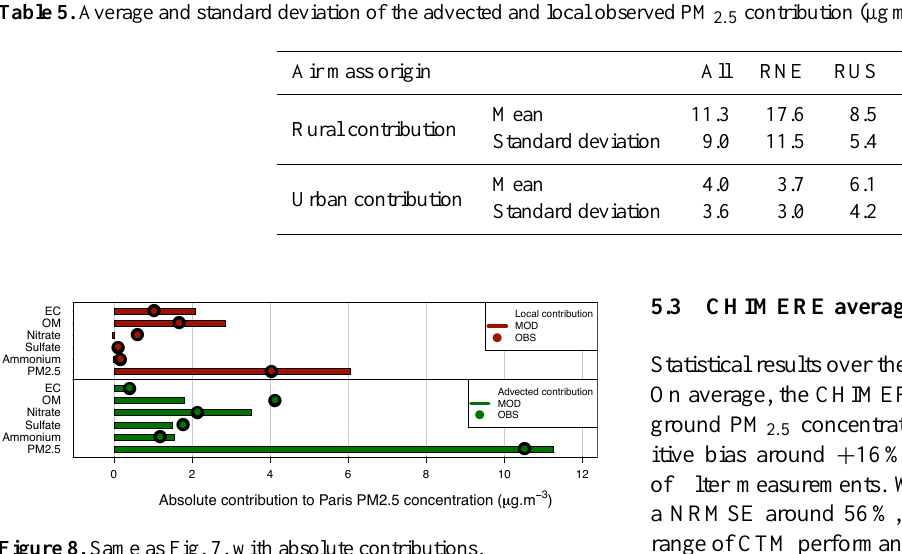
Figure 8. Same as Fig. 7, with absolute contributions. Table 6. Observed yearly advected and local relative contributions to urban background PM 2 . 5 (and its major chemical constituents) in